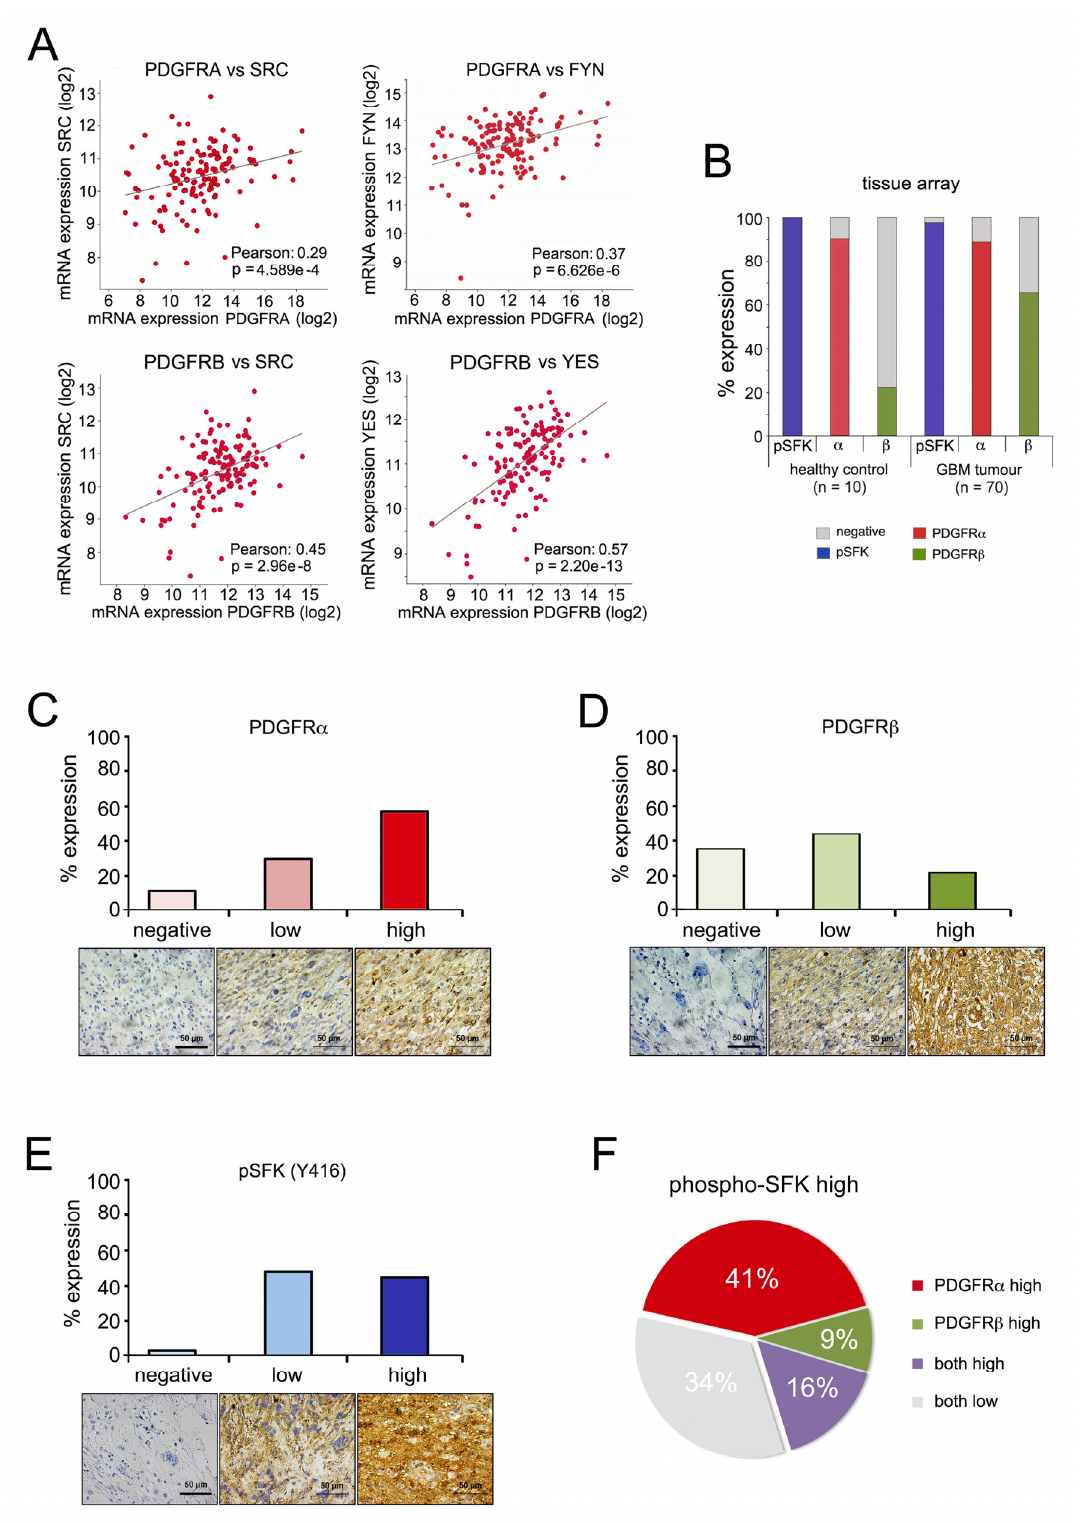
Figure 4. PDGFR and SRC kinase co-expression in high-grade gliomas. ( A ) Co-expression analysis of the indicated genes from the TCGA Glioblastoma dataset. ( B ) Overall expression of pSKF (using a phospho-SRC antibody), PDGFRA and PDGFRB in a TMA containing 70 stage 4 Glioblastoma and 10 healthy cerebrum tissue samples. ( C ) Quantification of relative PDGFRA expression in TMA GBM samples; scale bar, 50 µ m. ( D ) Quantification of relative PDGFRB expression in TMA GBM samples; scale bar, 50 µ m. ( E ) Quantification of relative pSFK expression in TMA GBM samples; scale bar, 50 µ m. ( F ) Quantification of relative expression of PDGFRA and PDGFRB in high pSFK tumour